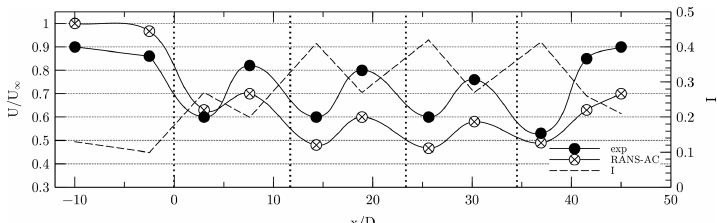
Figure 11. Wake across the turbine array. The axis for I is located at the right side of the plot. Vertical dotted lines signify the locations of each turbine.